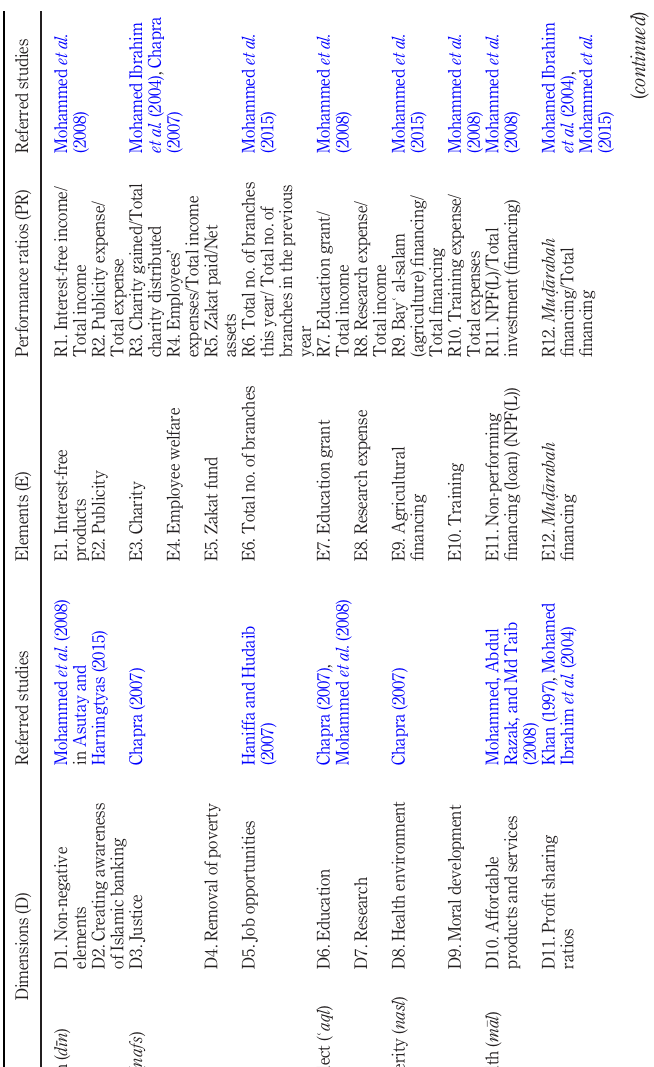
Table I. Integrated maq (cid:1) a (cid:1) sid al-Shar ī ʿ ah -based performance measure